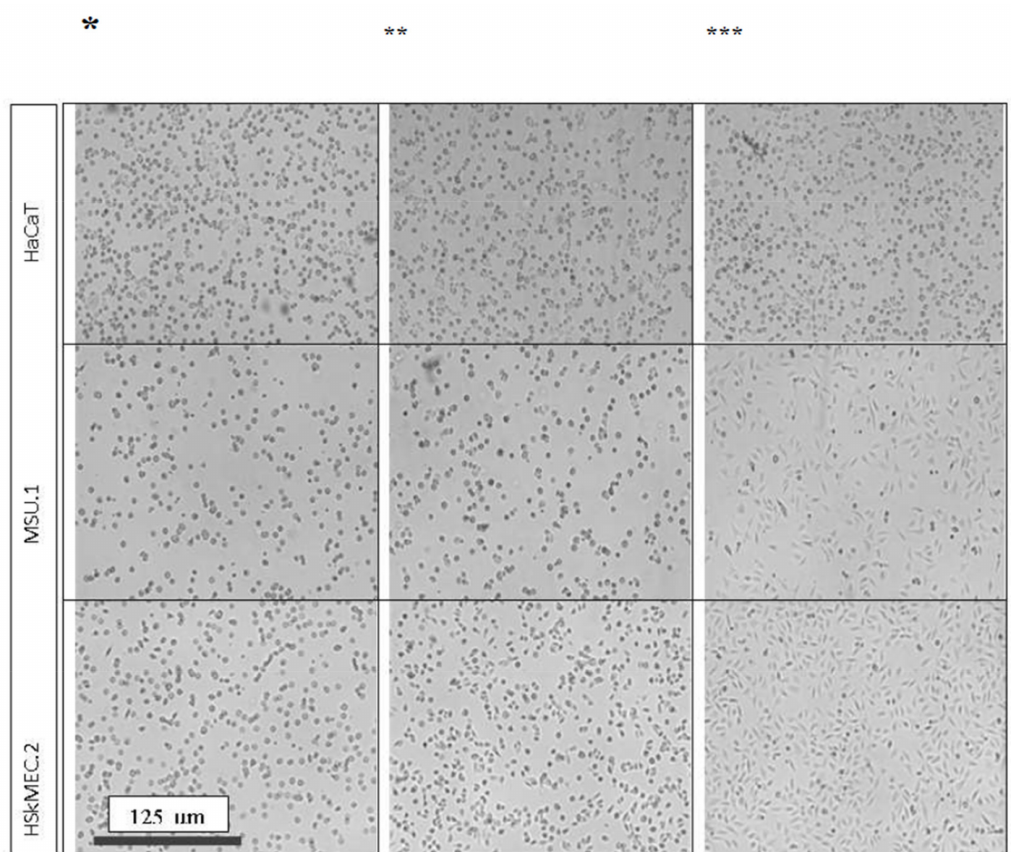
Figure 13. The influence of the HATMSC1 supernatant on the adhesion of cells involved in wound healing (keratinocytes HaCAT, fibroblasts MSU-1.1 and skin endothelial cells HSkMEC.2 to culture plastic). Pictures taken 1.5-2 h after plating